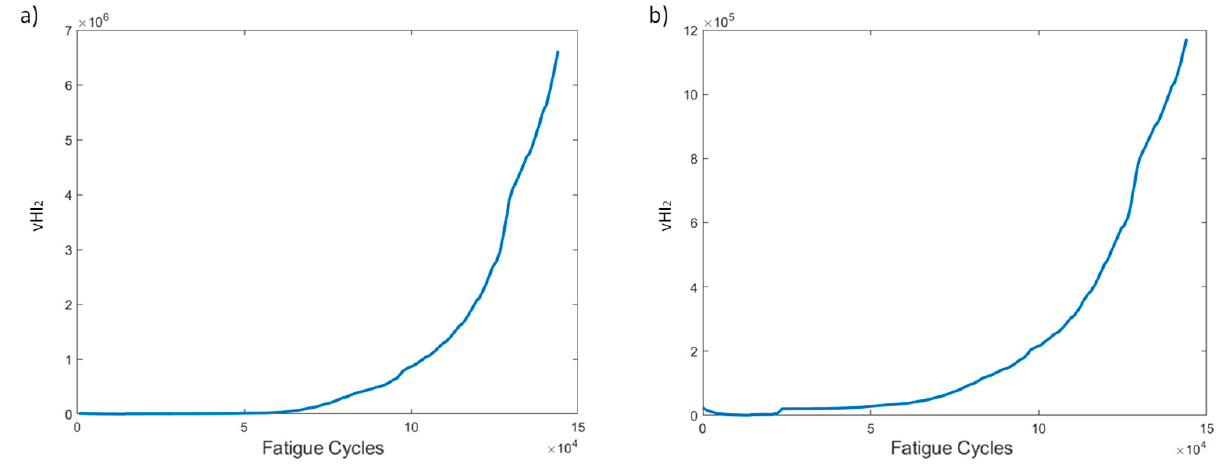
Figure 10. vHI 2 progression through time for the two pre-processing methods for specimen CA-2: ( a ) method 1, ( b ) method 2.